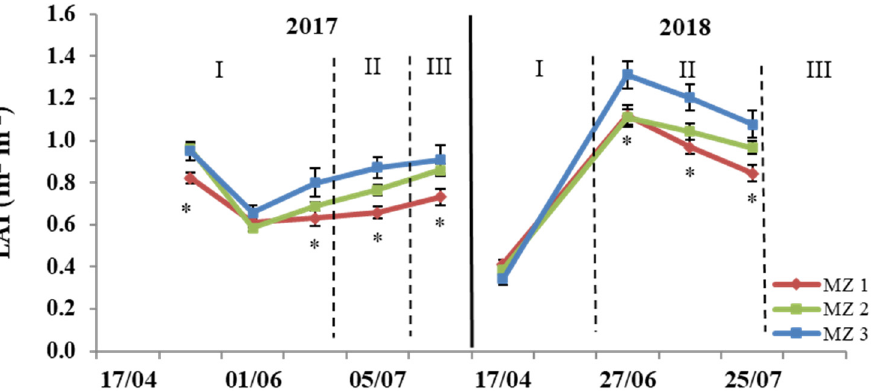
Figure 6. Seasonal course of leaf area index (LAI) of vines in the management zones (MZs) during 2017 and 2018. Each point is the mean of 44, 56 and 20 vines for MZ 1, 2 and 3, respectively ± SE. Asterisks represent significant differences among MZs using ANOVA ( α = 0.05).